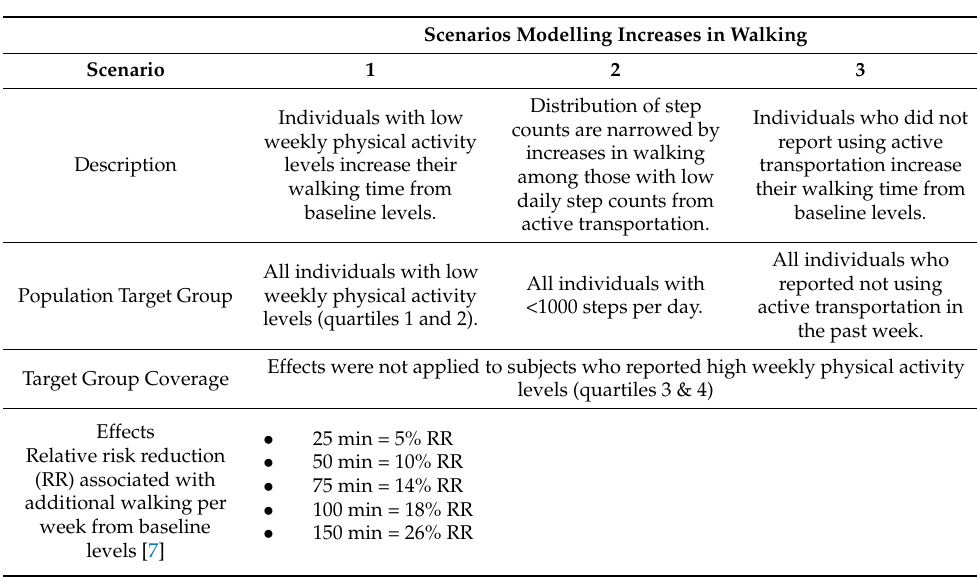
Table 1. Summary of population targets and effects used to define each scenario modelling the impact of increases in walking on